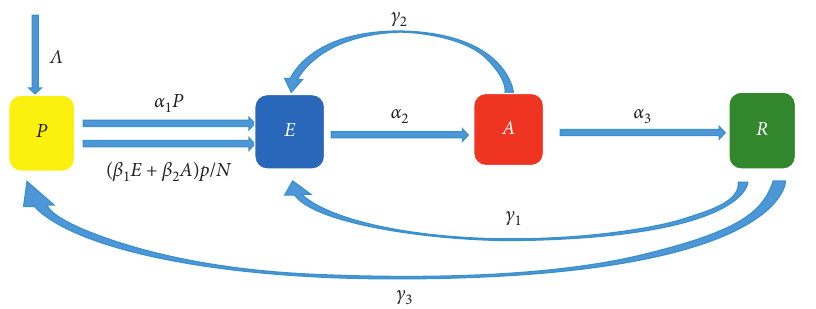
Figure 2: Illustration of movement between compartments.